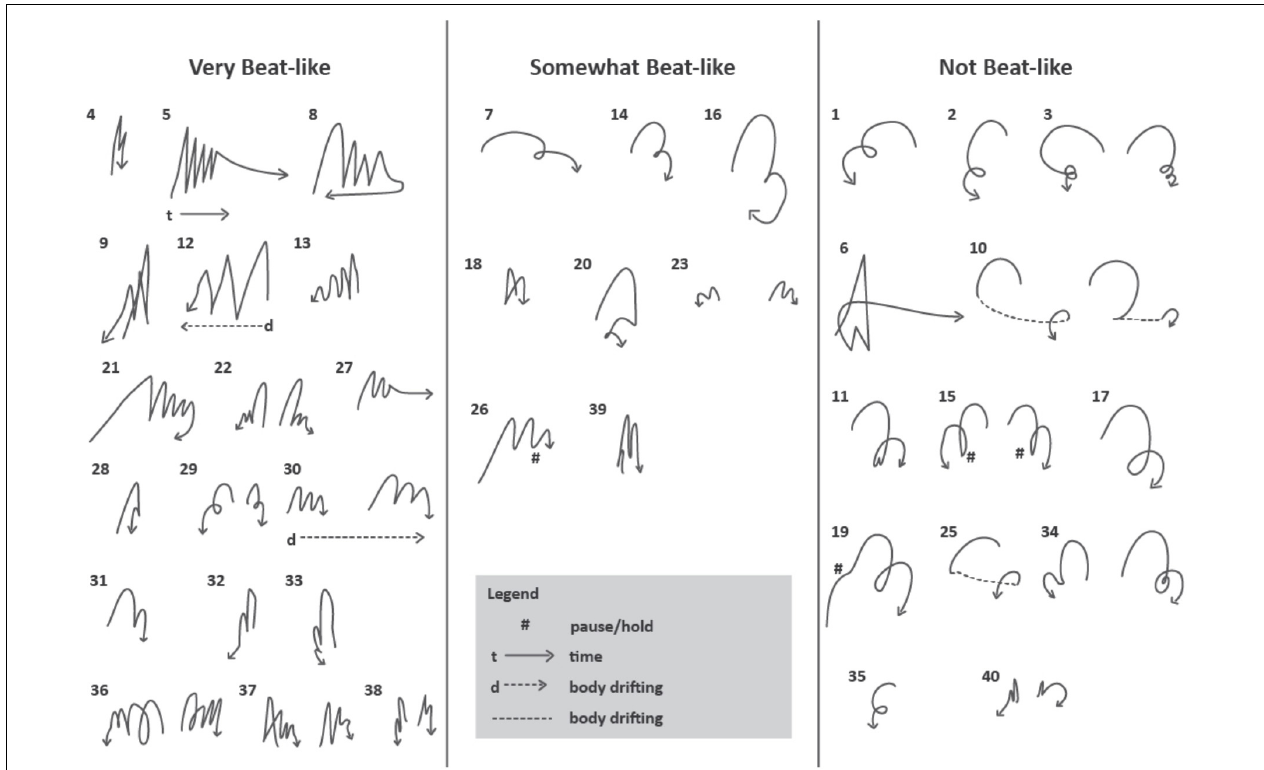
FIGURE 5 | Gesture sequences judged to be beat-like, somewhat beat-like and not-beat-like for the first 43 PGGs in the London sample. For discussion of the characterization of these sets, see